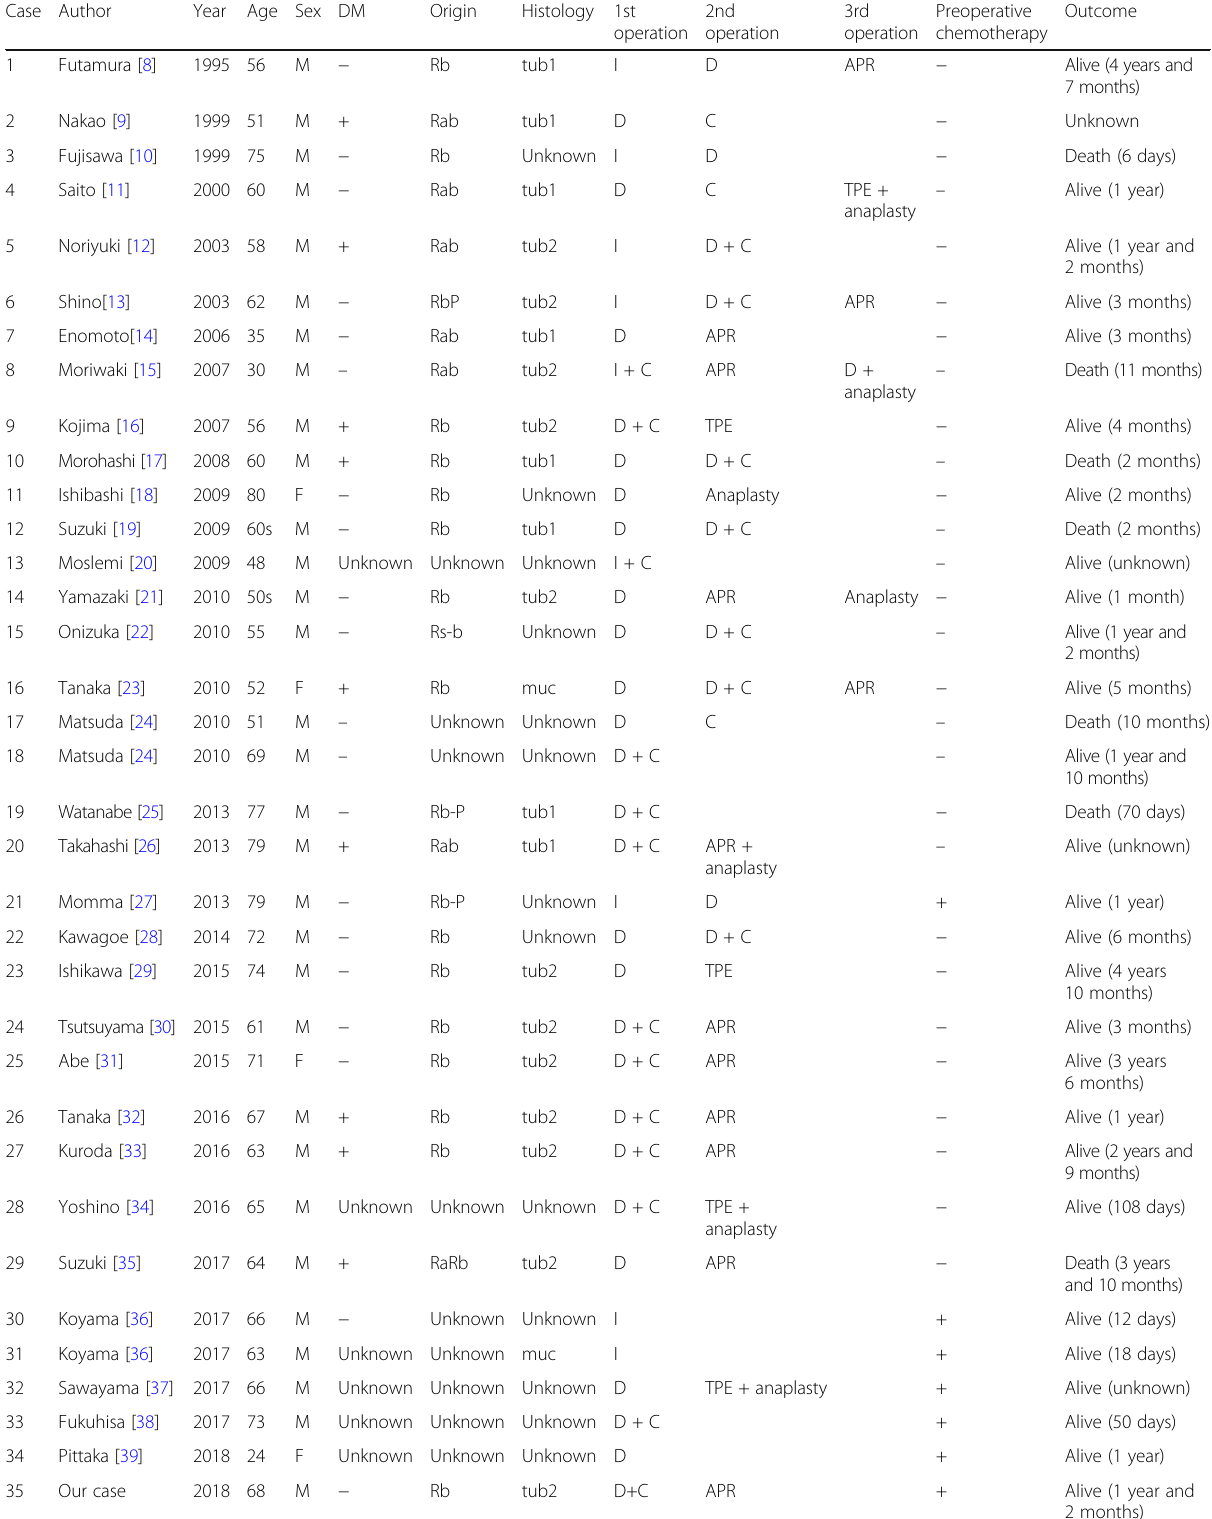
Table 1 Clinical data of patients of Fournier ’ s gangrene caused by penetration of rectal